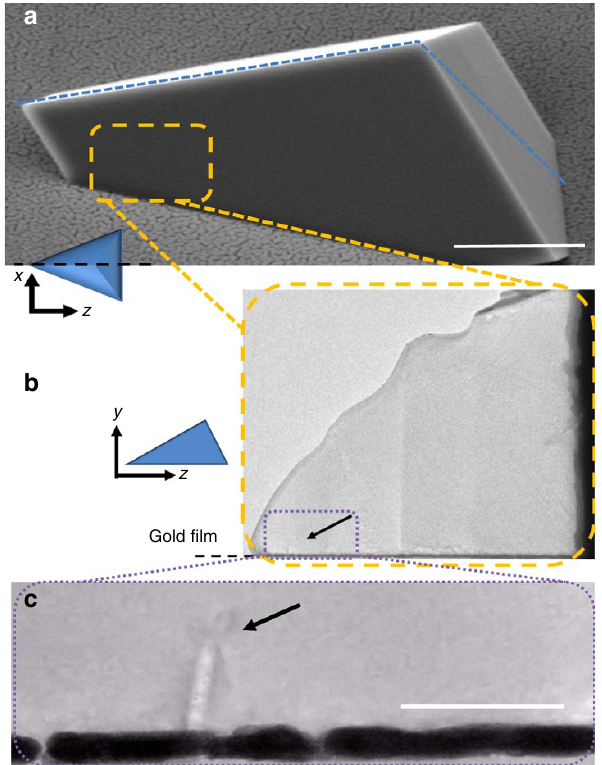
Figure 3 | Electron micrographs of oriented sections of precipitated calcite crystals. ( a ) Scanning electron microscope image of the sample crystal, where the dotted blue line shows the direction of the cut. Scale bar, 1 m m. ( b ) The selectively thinned tip of the prepared lamella, whose location with respect to the original crystal is indicated in the yellow box shown in a . ( c ) Shows a higher-magnification image of the front end of the tip (arrowed in b ). Arrowed in c is a feature of size B 85 (cid:3) 15nm, which corresponds to the ‘surface cusps’ imaged using BCDI. Scale bar,